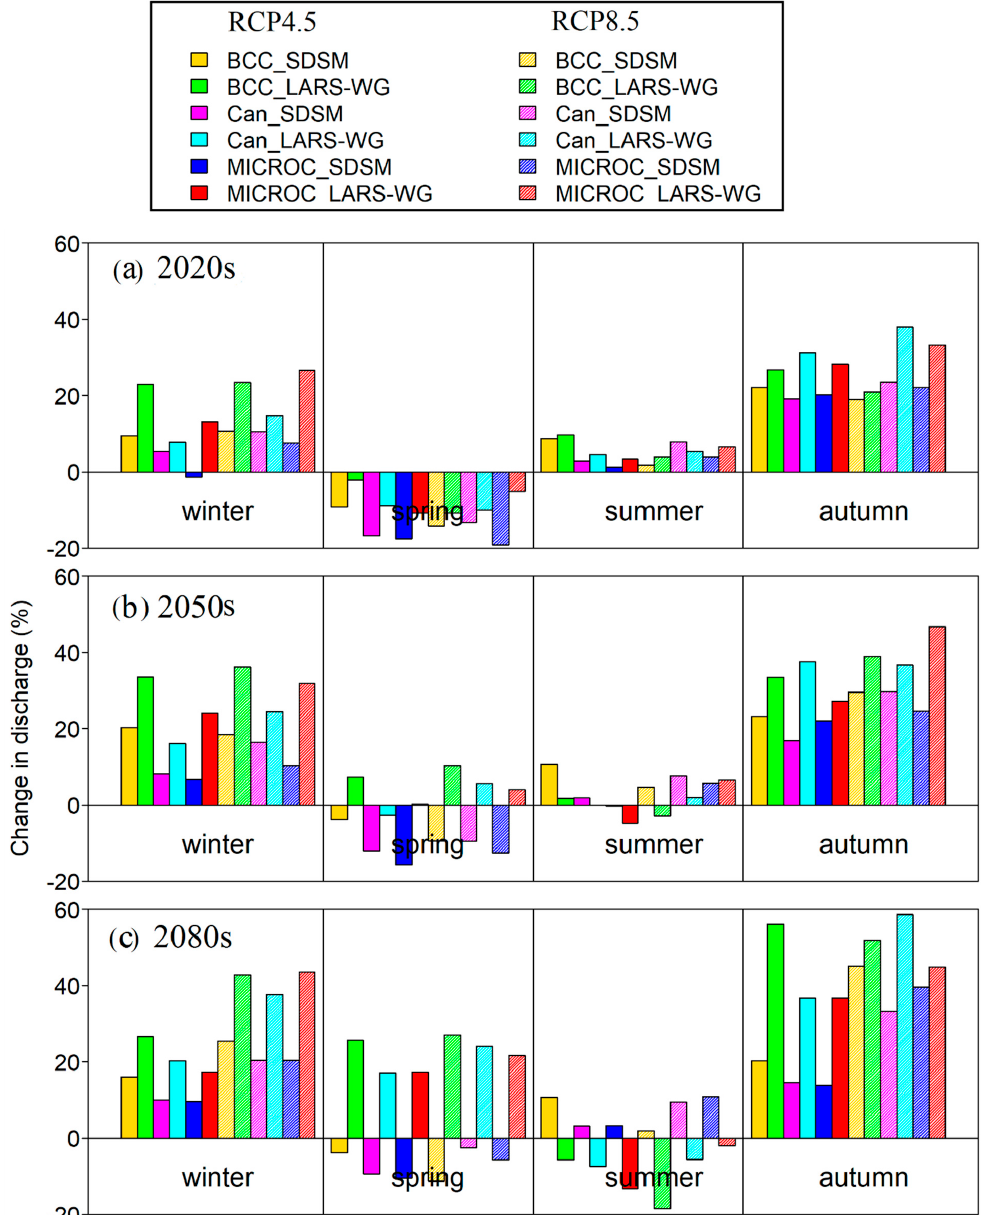
Figure 8. Changes in seasonal discharge (relative to baseline) with SDSM and LARS-WG in three future periods ( a ) 2020s, ( b ) 2050s, and ( c ) 2080s under RCP4.5 and RCP8.5.